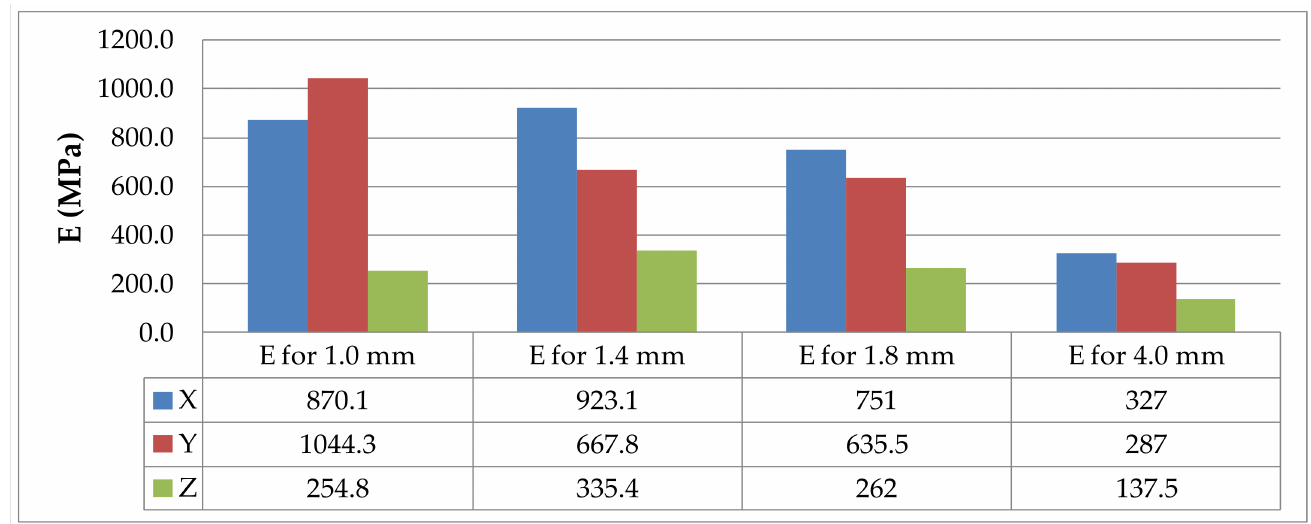
Figure 26. Elasticity modulus E for the PLA-CF specimens differing in thickness and print direction, where X, Y and Z are printing